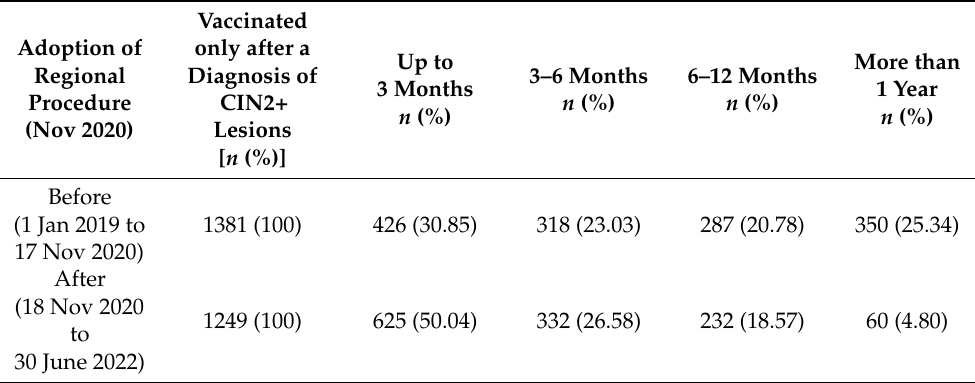
Table 5. Distribution of previously-unvaccinated women by time elapsing between being diagnosed with CIN2+ lesions at 1st-level screening and a first dose of HPV vaccine, before and after the introduction of the regional procedure.